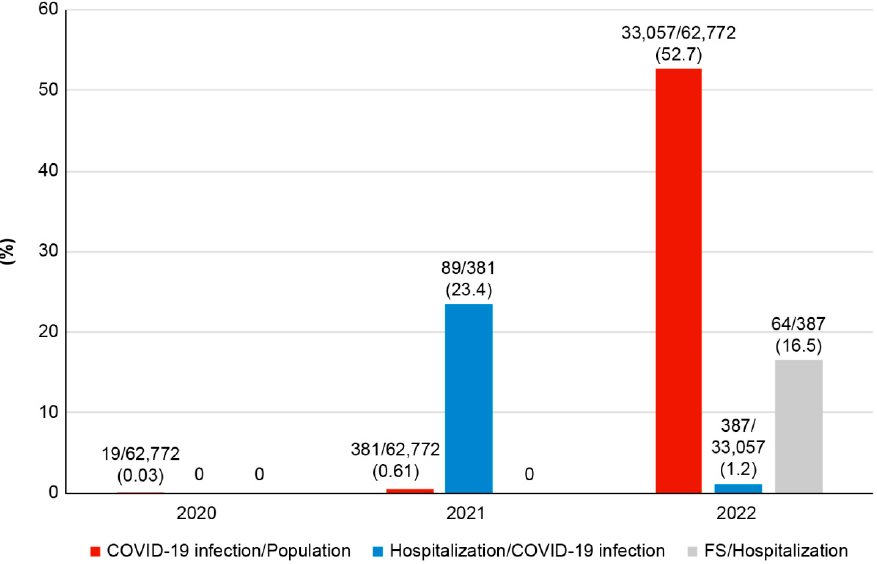
Figure 1. Confirmed COVID-19 cases, hospitalization rates, and febrile seizures according to sex.